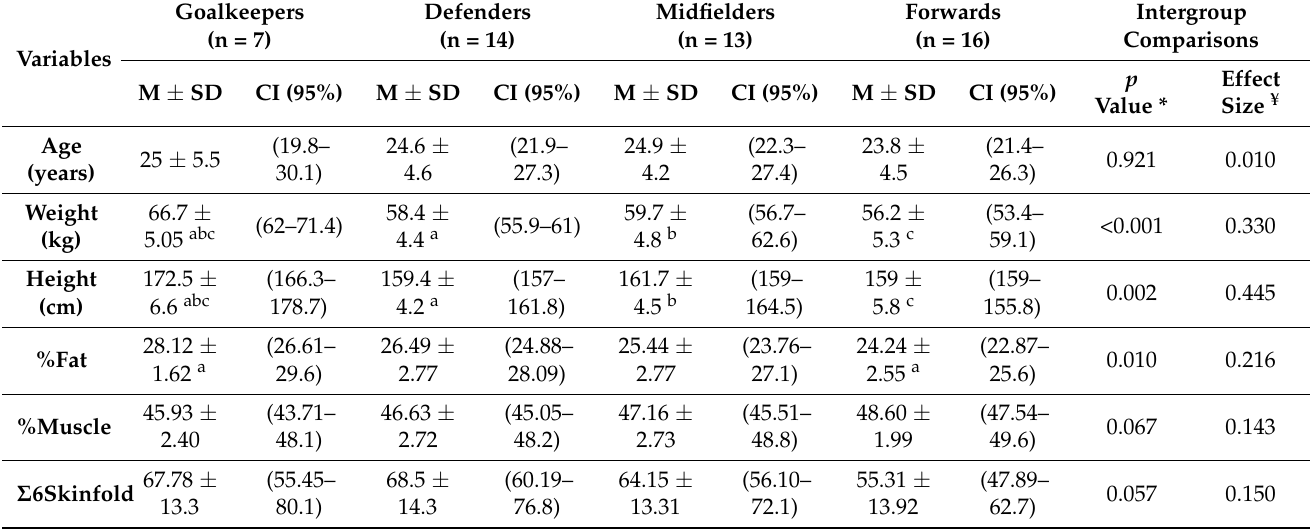
Table 1. Anthropometric variables by playing positions. Mean ± standard deviation (M ± SD) and 95% confidence interval (CI 95%).